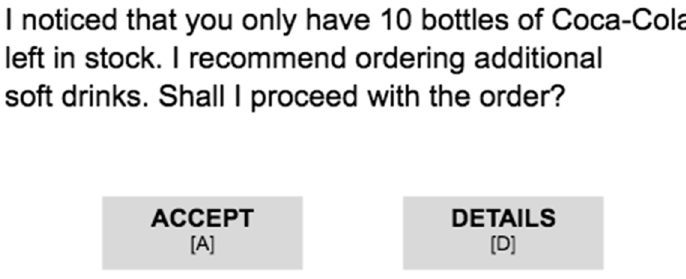
Figure 3. Example of study stimulus.